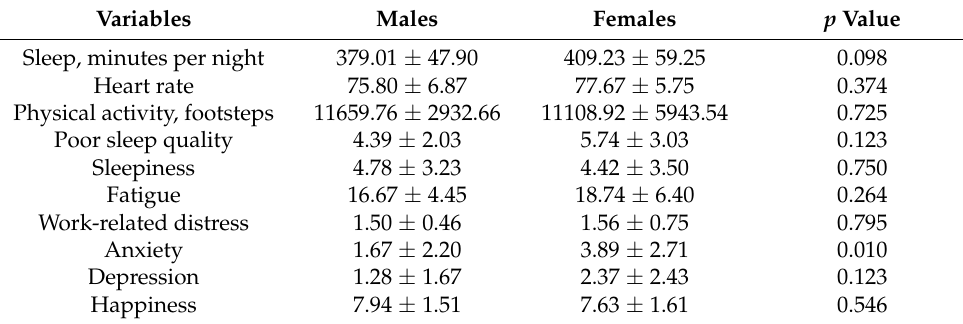
Table 3. Gender-related differences in sleep and health-related variables.